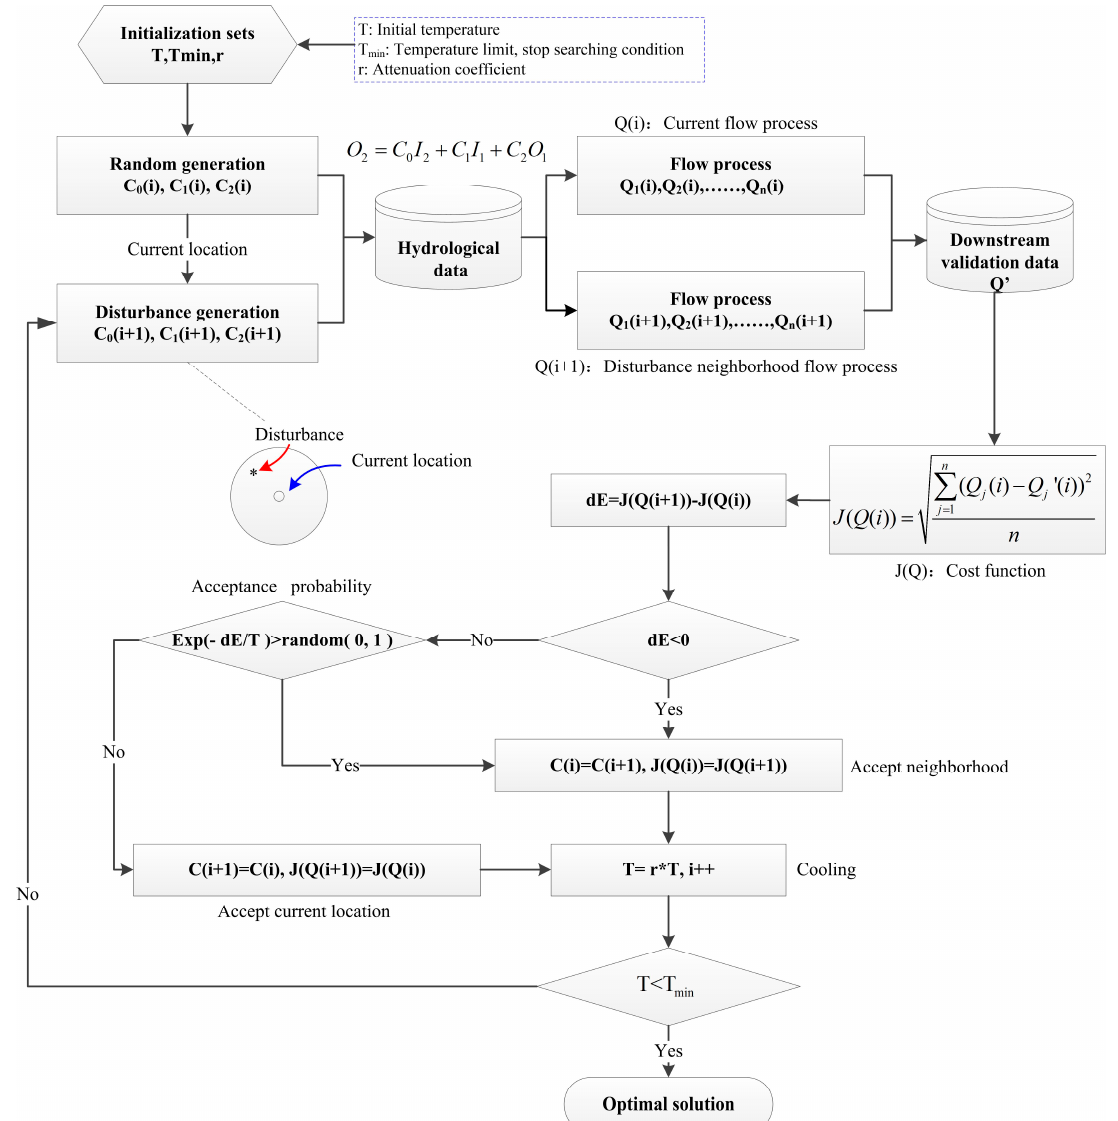
Figure 3. Simulated annealing algorithm flow chart.